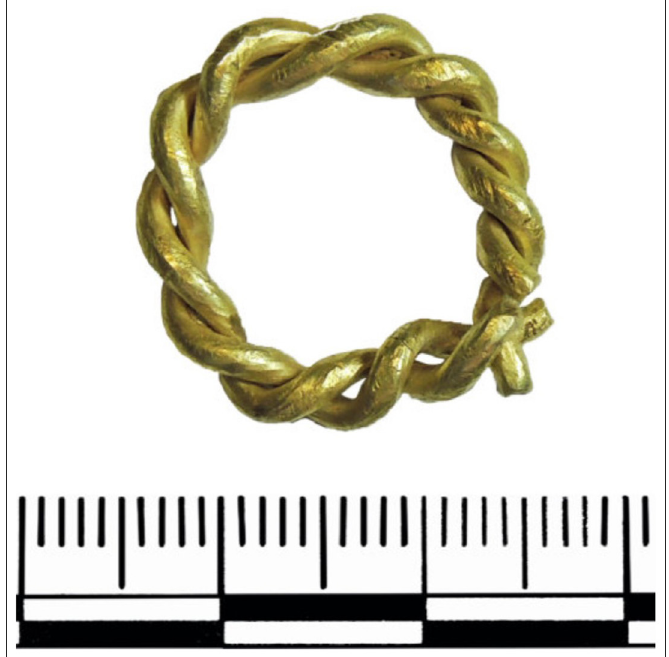
Figure 1: Two strands of circular cross-section wire that have been twisted together, suspected section of golden Iron Age Torc found in Gloucestershire (Image curtsey of the Portable Antiquities Scheme, Record ID: